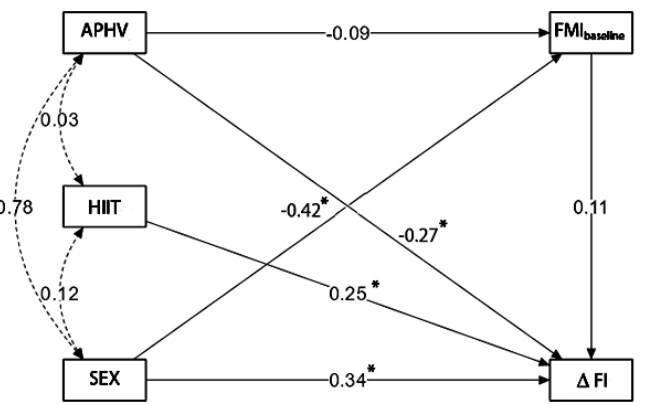
Figure 1. The path model, constructed for all participants (including boys and girls), shows the as- sociation between changes in FI and APHV, HIIT intervention, and sex as exogenous variables with the preintervention FMI. Abbreviations: APHV—age at peak height velocity, HIIT—HIIT groups (EG-1 coded, CG-0 coded), SEX—males (1 coded) and females (0 coded), FMI baseline —fat mass index preintervention, ΔFI—changes in fitness index, *—statistically significant path.